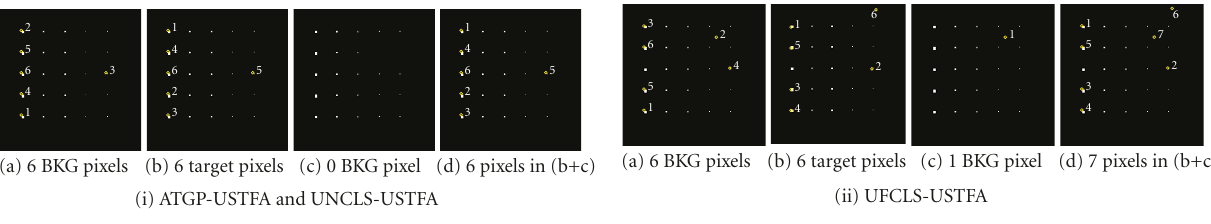
Figure 5: Target pixels extracted by three unsupervised algorithms ATGP-USTFA, UNCLS-USTFA, and UFCLS-USTFA for scenario TE.